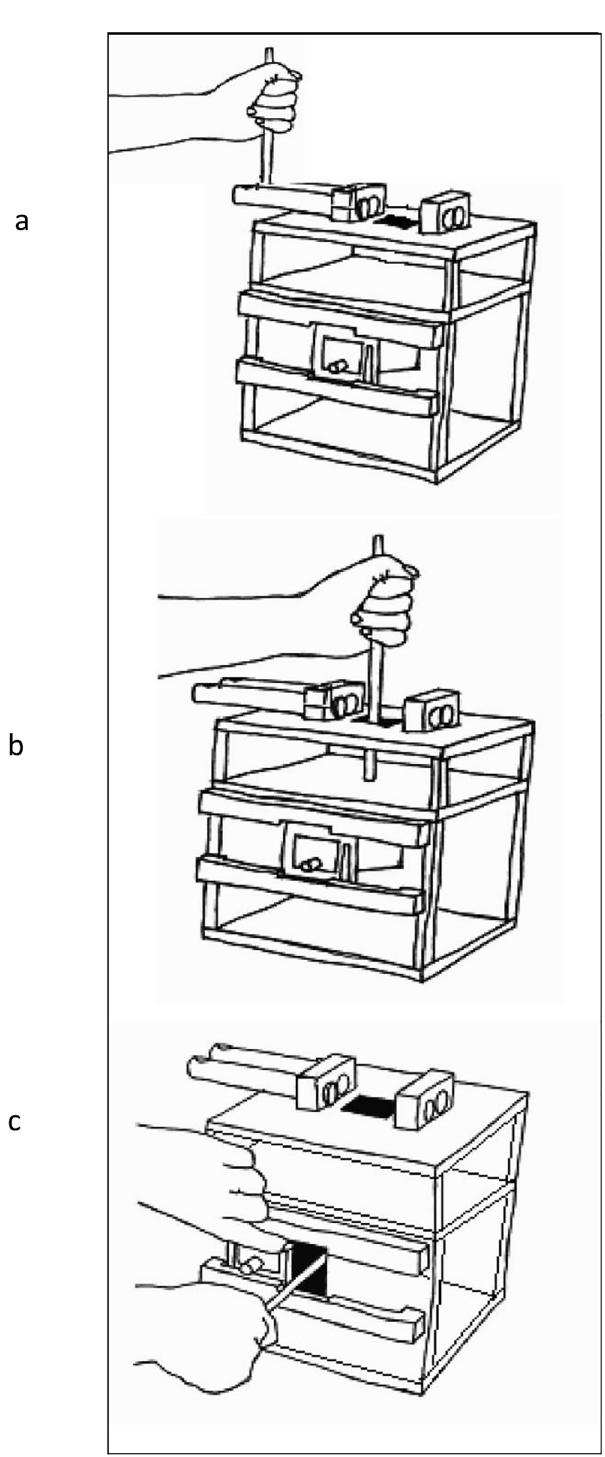
Fig 1. The ‘ model ’ demonstrates a series of actions, some of which are irrelevant to goal retrieval (removing bolt defence, inserting tool into top hole), and some which are relevant to goal retrieval (removing door defence, inserting tool into lower hole). These actions are illustrated above: (a) dragging bolt; (b) causally irrelevant tool insertion into top hole; (c) causally relevant tool insertion into front hole.